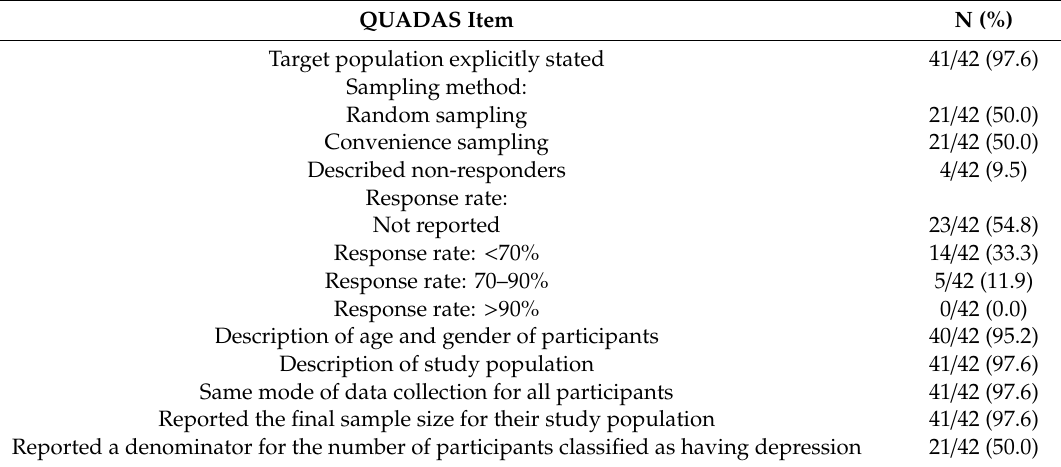
Table 2. Results of the risk of bias assessment for the 42 included studies using a modified Quality Assessment of Diagnostic Accuracy Studies (QUADAS)